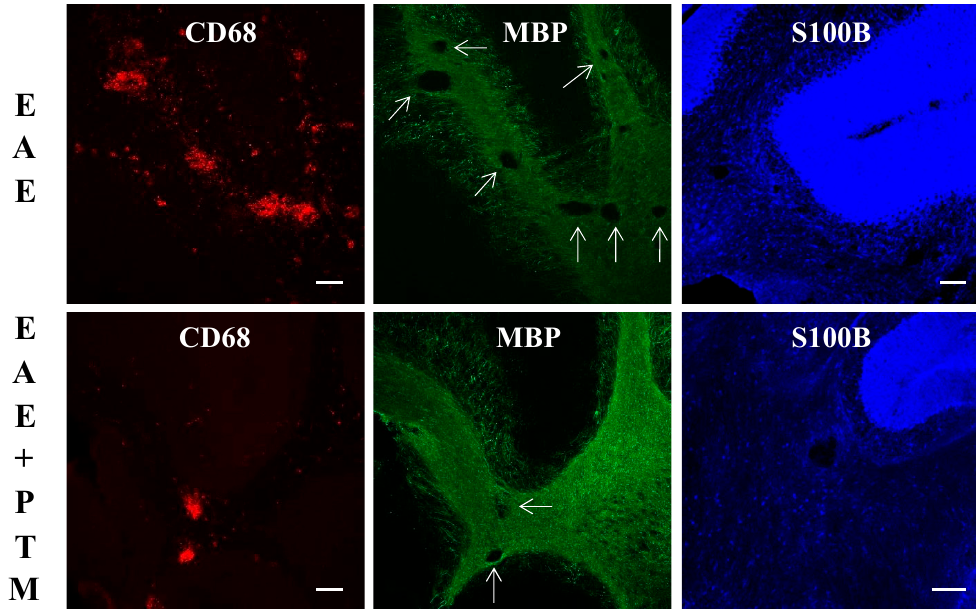
Figure 4. Immunofluorescence in representative cerebellar sections of EAE mice and PTM-treated EAE mice. CD68-labelled infiltrates accompanied by demyelinating lesions (arrows) are evident in EAE mice, which appear to be reduced in PTM-treated EAE mice, as shown by CD68 (red) and MBP (green) signals. Decreased S100B immunolabelling (blue) also appears in PTM-treated EAE mice. Scale bars = 100 μ m.